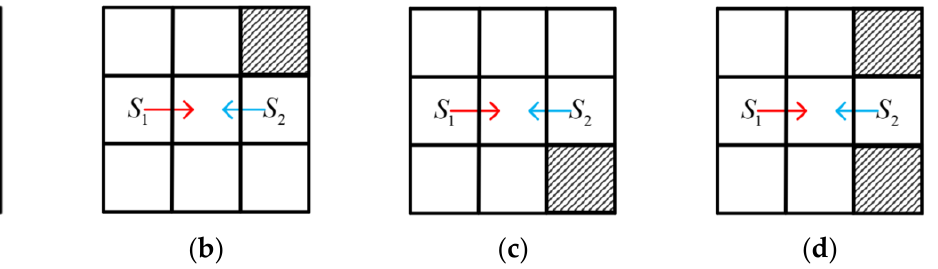
Figure 5. Schematic diagram of the first type of collision avoidance. ( a ) Situation 1; ( b ) Situation 2; ( c ) Situation 3; ( d ) Situation 4.